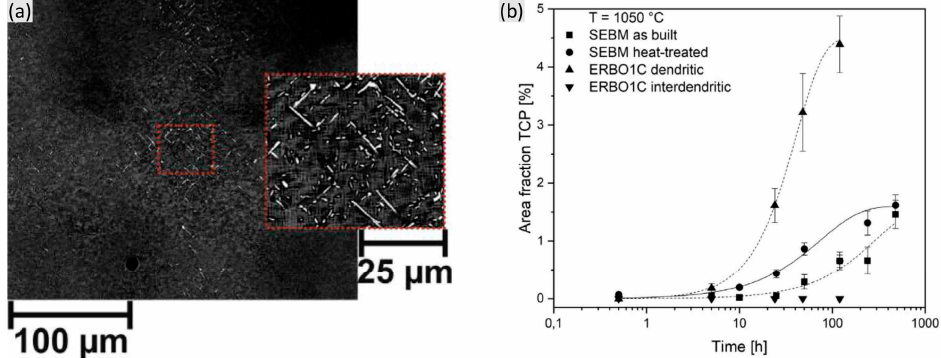
Figure 8. ( a ) Microstructure of the ERBO/1C alloy after thermal exposure at 1050 °C for 120 h and ( b ) area fraction of formed TCPs in dendritic core and interdendritic region [51].